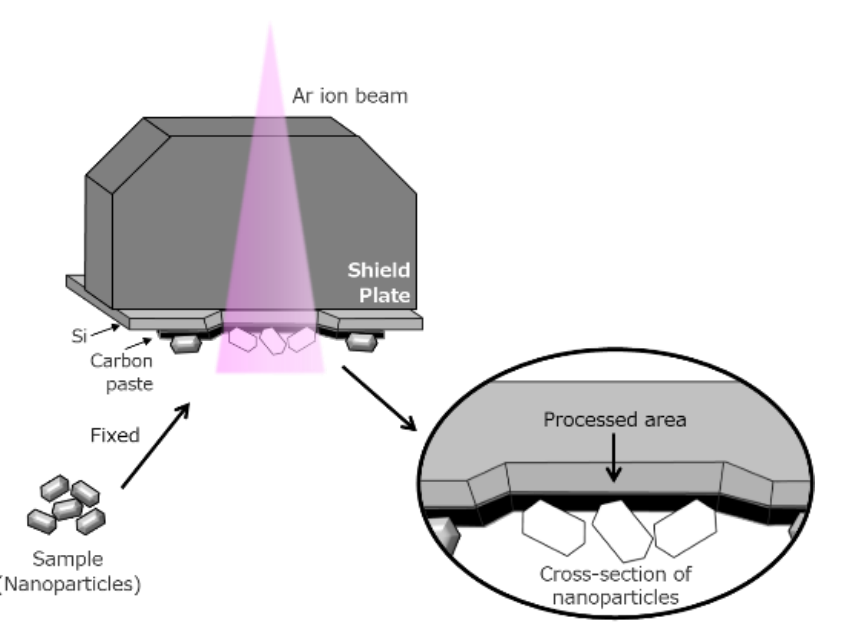
Figure 2. Precise cross sectioning using broad Ar ion beam.